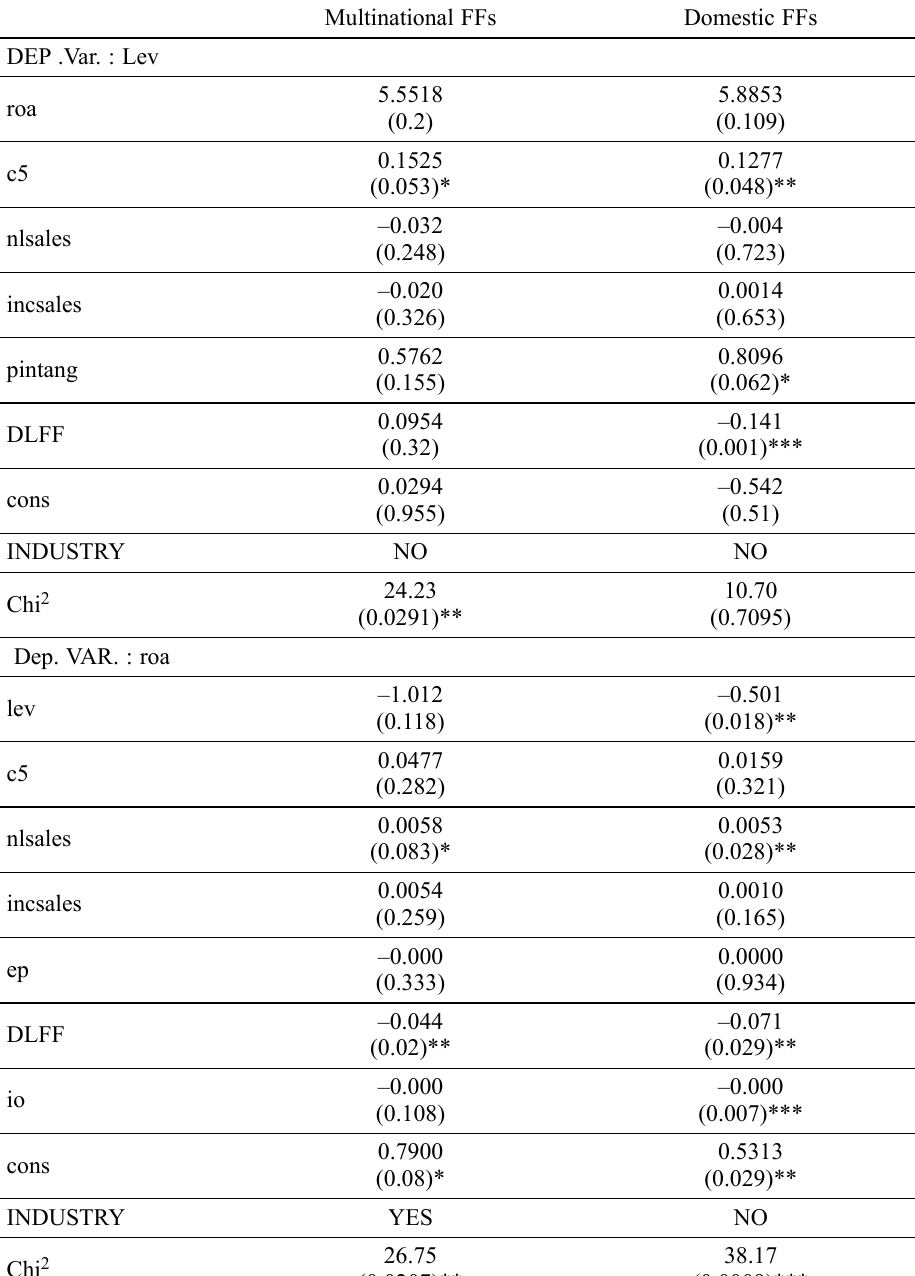
Table 4. Results from the simultaneous equations model. Multinational FFs vs. domestic FFs Multinational FFs Domestic